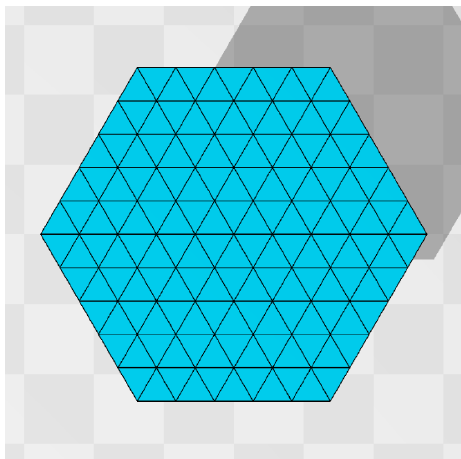
Figure 1. A hexagonal lattice discretized by regular triangles. The total number of vertices N including those on the boundary is given by N = 91. This number is calculated by the formula N = 3 L 2 + 3 L + 1, where L (= 5 ) is the number of division of the edge of the original hexagon. This type of hexagonal lattice is used to define discrete Hamiltonians of the surface models studied in this